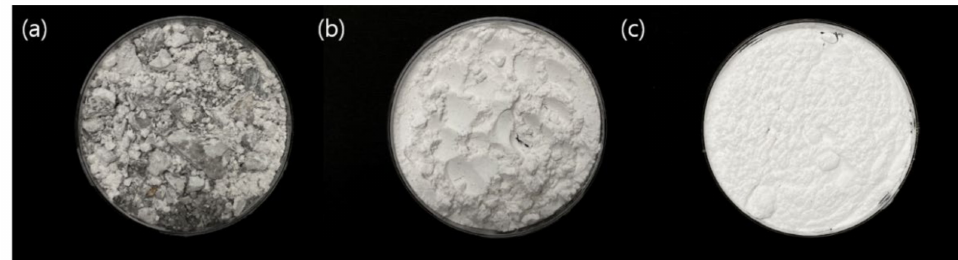
Figure 5. Calcinated samples by the experimental group: ( a ) CC6. ( b ) CC7. ( c )